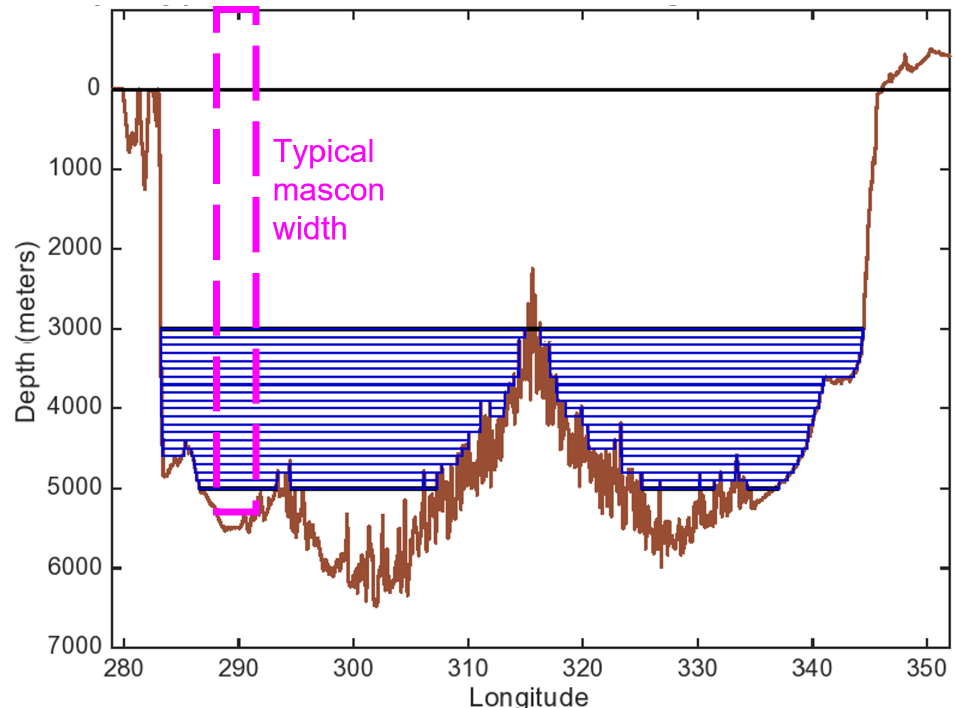
Figure 9. Depth-longitude section of the transect across the Atlantic Ocean at 26.5 ◦ N latitude. The brown line indicates the topography/bathymetry, and the magenta dashed rectangle the typical longitudinal width of a mascon in the JPL RL06M product. The blue rectangles indicate the bin segments (100 m depth each) used to compute the layer transport